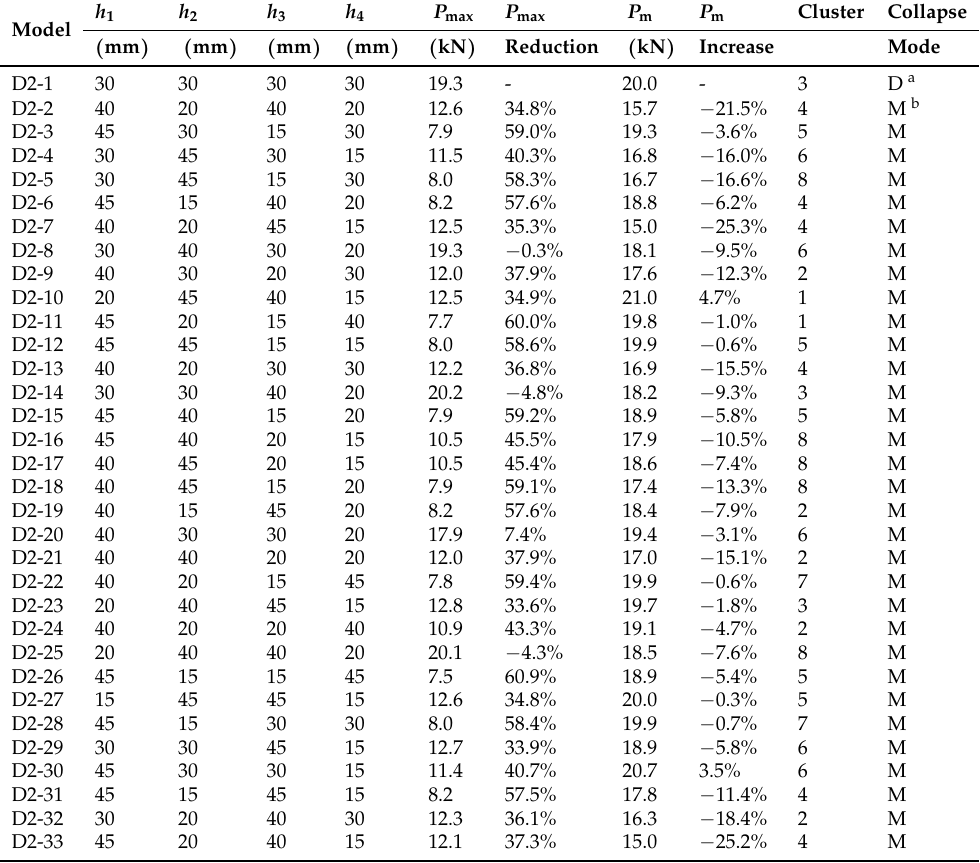
Figure 3. Origami tubes with different crease spacing. The model numbers in the paper are D2-25, D2-21, D2-2, D2-8 and D2-27, respectively. Table 1. Distribution of crease parameters and numerical